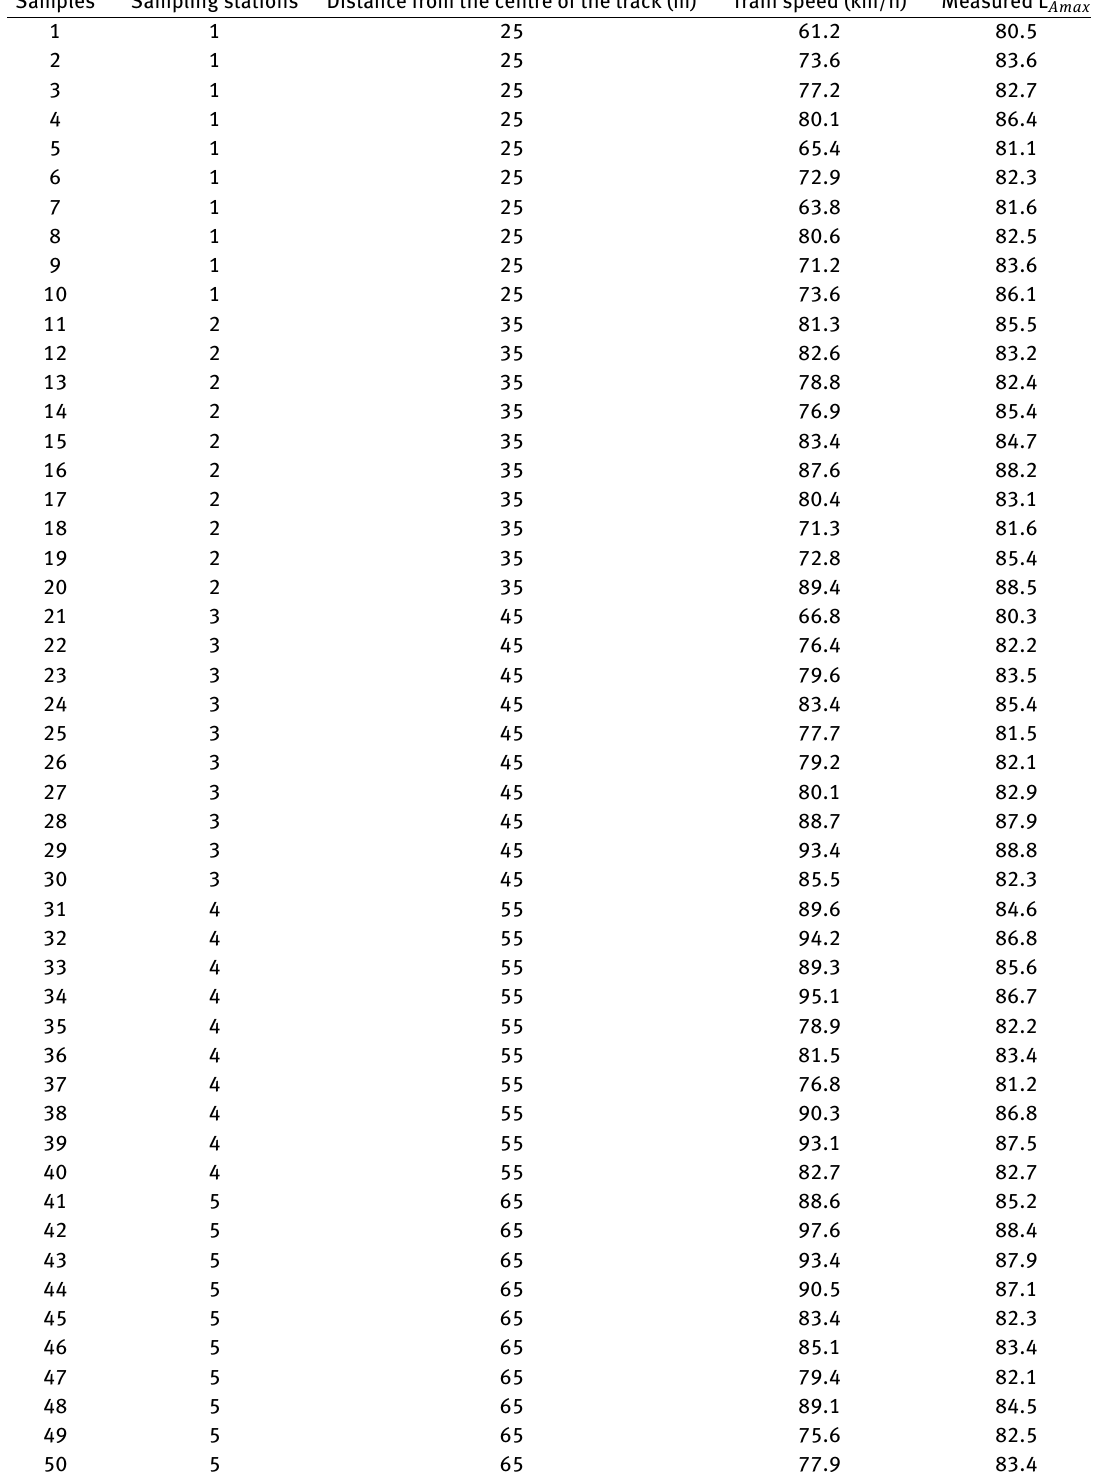
Table 1: The specifications of the samples